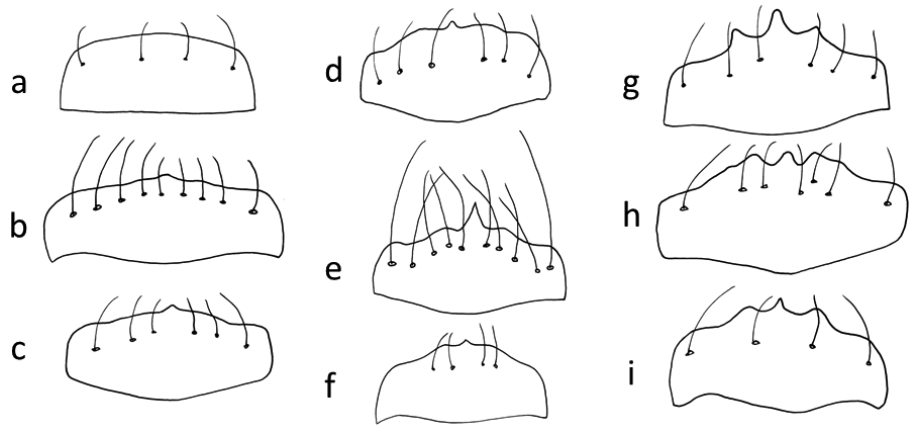
Figure 6. Labrum of tiger beetles: a without a tooth ( Myriochila melancholica ) b, c, d, e, f with 1 tooth ( b Cylindera contorta valdenbergi c Cephalota littorea d Cicindela javetii e Cylindera rectangularis f Cephalota vartianorum ) g, i with 3 teeth ( g Cicindela asiatica i Myriochila orientalis ) h with 3 to 5 teeth ( h Cephalota tibialis